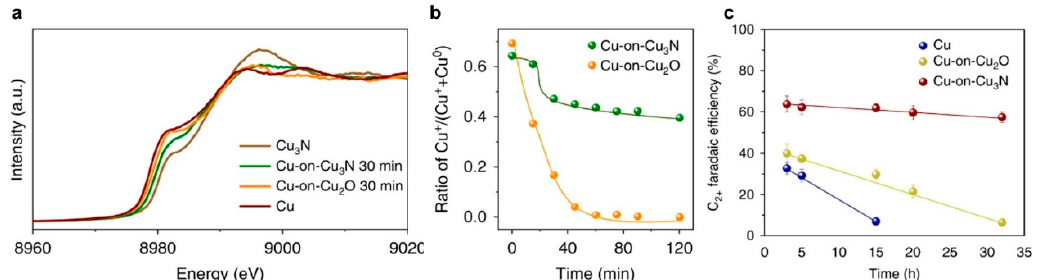
Figure 14. The effects of various support materials for a Cu catalyst: ( a ) in situ Cu K ‐ edge spectra obtained during the initial 30 min for the supported catalysts Cu ‐ on ‐ Cu 3 N (green) and Cu ‐ on ‐ Cu 2 O (orange), along with reference spectra for Cu (red) and Cu 3 N (yellow); ( b ) the ratio of Cu + to reaction time at − 0.95 V vs. RHE; ( c ) the stability of Cu, Cu ‐ on ‐ Cu 2 O, and Cu ‐ on ‐ Cu 3 N towards C 2+ selectivity (reprinted with permission from ref. [119], copyright 2018, Springer Nature).